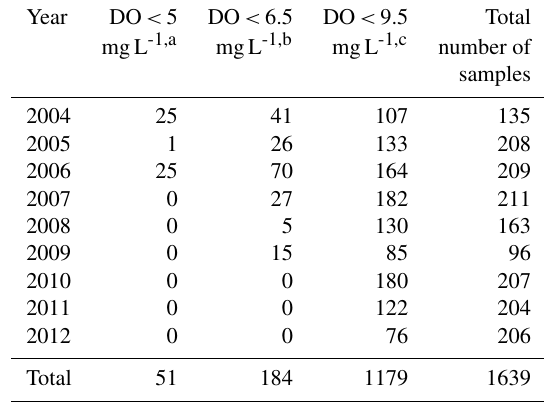
Table 1. A summary of low DO events in the Bow River be- tween 2004 and 2012 and the corresponding minimum acceptable DO concentration